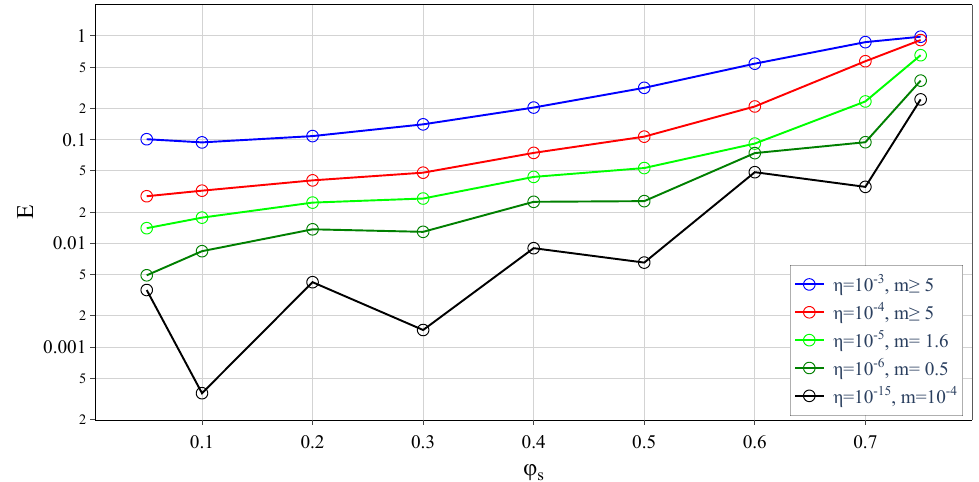
Figure 4. The plot of relative error E = ( f num f ) / f versus the solid volume fraction ϕ s for the − fixed level of refinement J max = 9 and different penalization coefficients η . The value m denotes the number of cells needed to resolve the Brinkman layer in Equation (11).